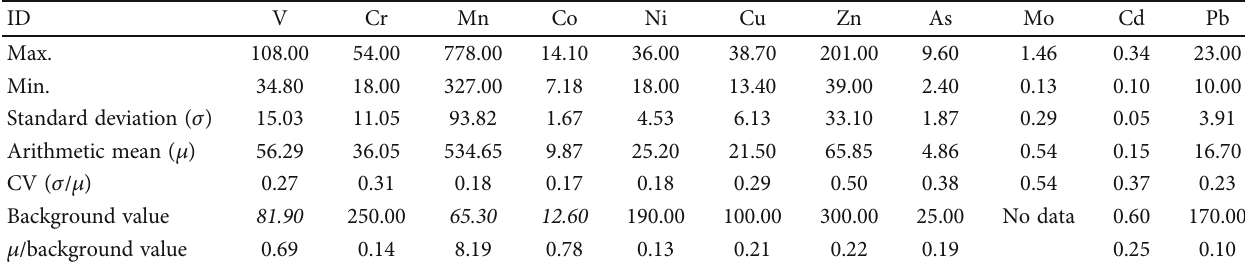
Table 1: Statistical results of heavy metal concentrations (mg/kg) in this